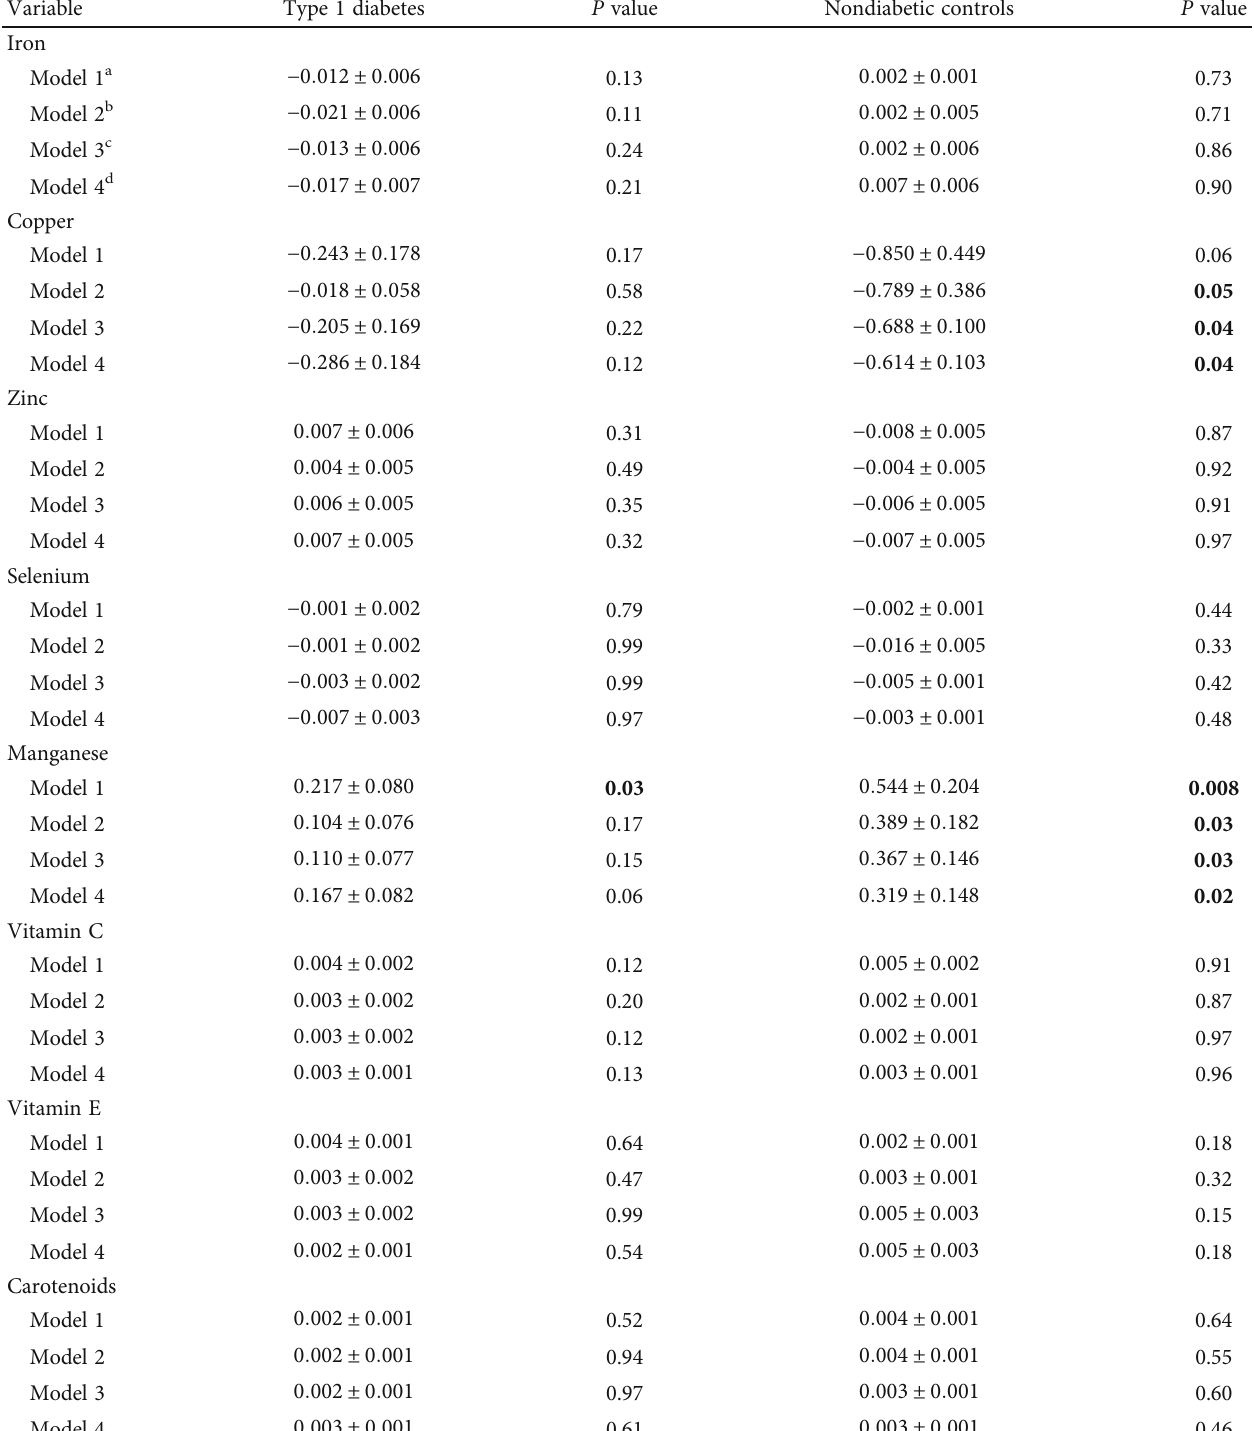
Table 3: Cross-sectional associations of dietary antioxidant micronutrients with estimated insulin sensitivity ( β ± standard error ).